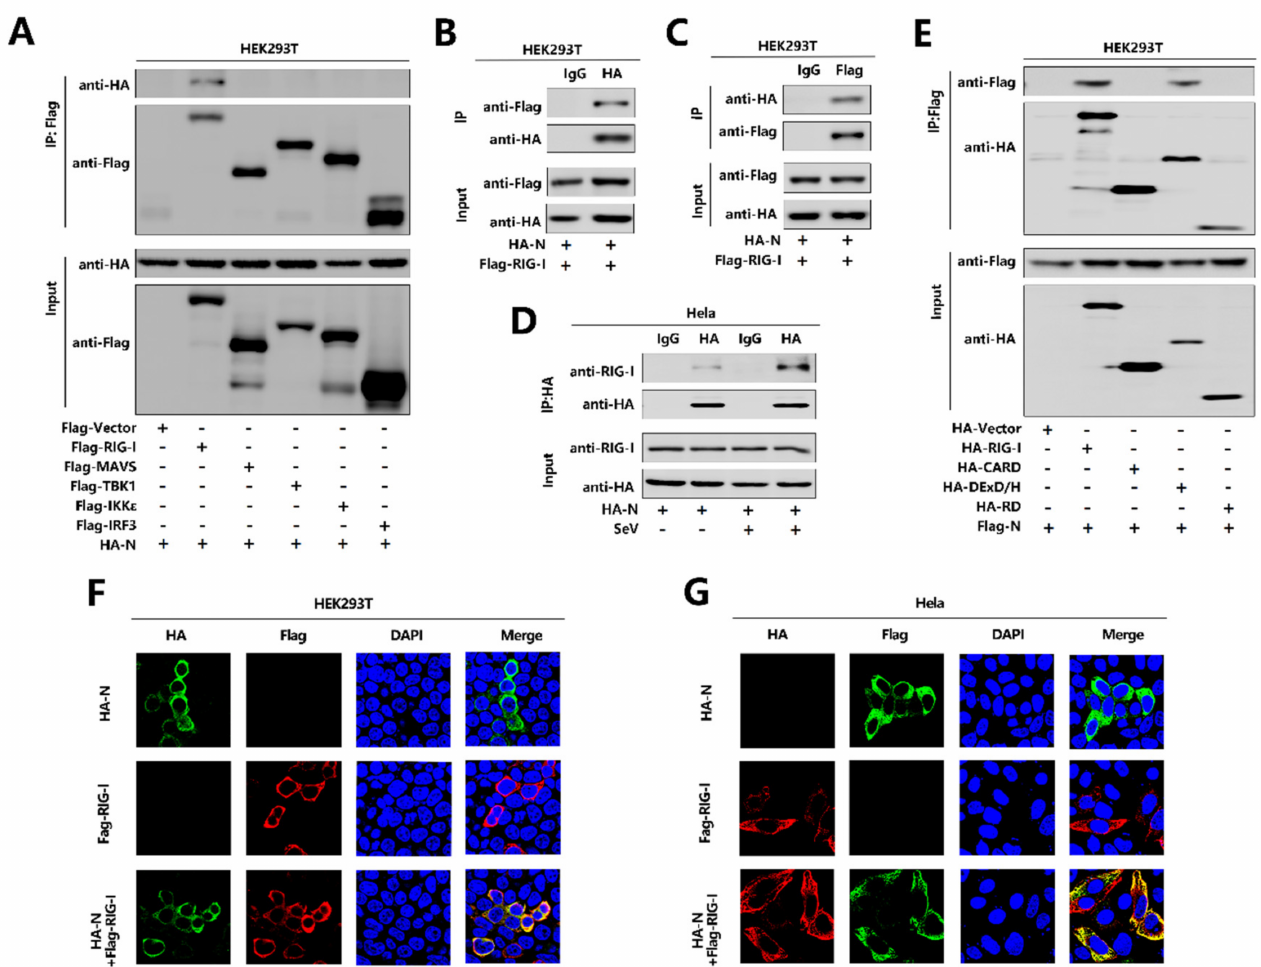
Figure 4. SARS-CoV-2 N protein binds to the DexD/H domain of RIG-I. ( A ) HEK293T cells were co-transfected with pHA-N in combination with pFlag-Vector, pFlag-RIG-I, pFlag-MAVS, pFlag-TBK1, pFlag-IKK ε , or pFlag-IRF3. Cell lysates were subjected to immunoprecipitation (IP) using anti-Flag antibody and analyzed by immunoblotting using anti-HA and anti-Flag antibody (top). Cell lysates (30 µ g protein) were analyzed directly by immunoblotting using anti-HA and anti-Flag antibody as input (bottom). ( B , C ) HEK293T cells were co-transfected with pHA-N and pFlag-RIG-I. Cell lysates were subjected to IP using control IgG or anti-HA antibody ( B ) and control IgG or anti-Flag antibody ( C ). Cell lysates (30 µ g protein) were analyzed directly by immunoblotting using anti-HA and anti-Flag antibody as input (bottom). ( D ) Hela cells were transfected with pHA-N or transfected with pHA-N and infected with SeV (MOI = 0.1) for 16 h. Cell lysates were subjected to IP using control IgG and anti-HA antibody and then analyzed by immunoblotting using anti-HA antibody and anti-RIG-I antibody. Cell lysates (30 µ g protein) were analyzed by immunoblotting using anti-HA and anti-RIG-I antibody as input (bottom). ( E ) HEK293T cells were co-transfected with pFlag-N in combination with pHA-Vector, pHA- RIG-I-(2CARD), pHA-DExD/H, or pHA-RD. Cell lysates were subjected to IP using anti-Flag antibody and then analyzed by immunoblotting using anti-HA and anti-Flag antibody (top). Cell lysates (30 µ g protein) were analyzed directly by immunoblotting using anti-HA and anti-Flag antibody as input (bottom). ( F , G ) HEK293T cells ( F ) and Hela cells ( G ) were transfected with pHA-N or pFlag-RIG-I, or co-transfected with pFlag-RIG-I and pHA-N. The sub-cellular localizations of Flag-RIG-I (red), HA-N (green), and nucleus marker DAPI (blue) were analyzed by confocal